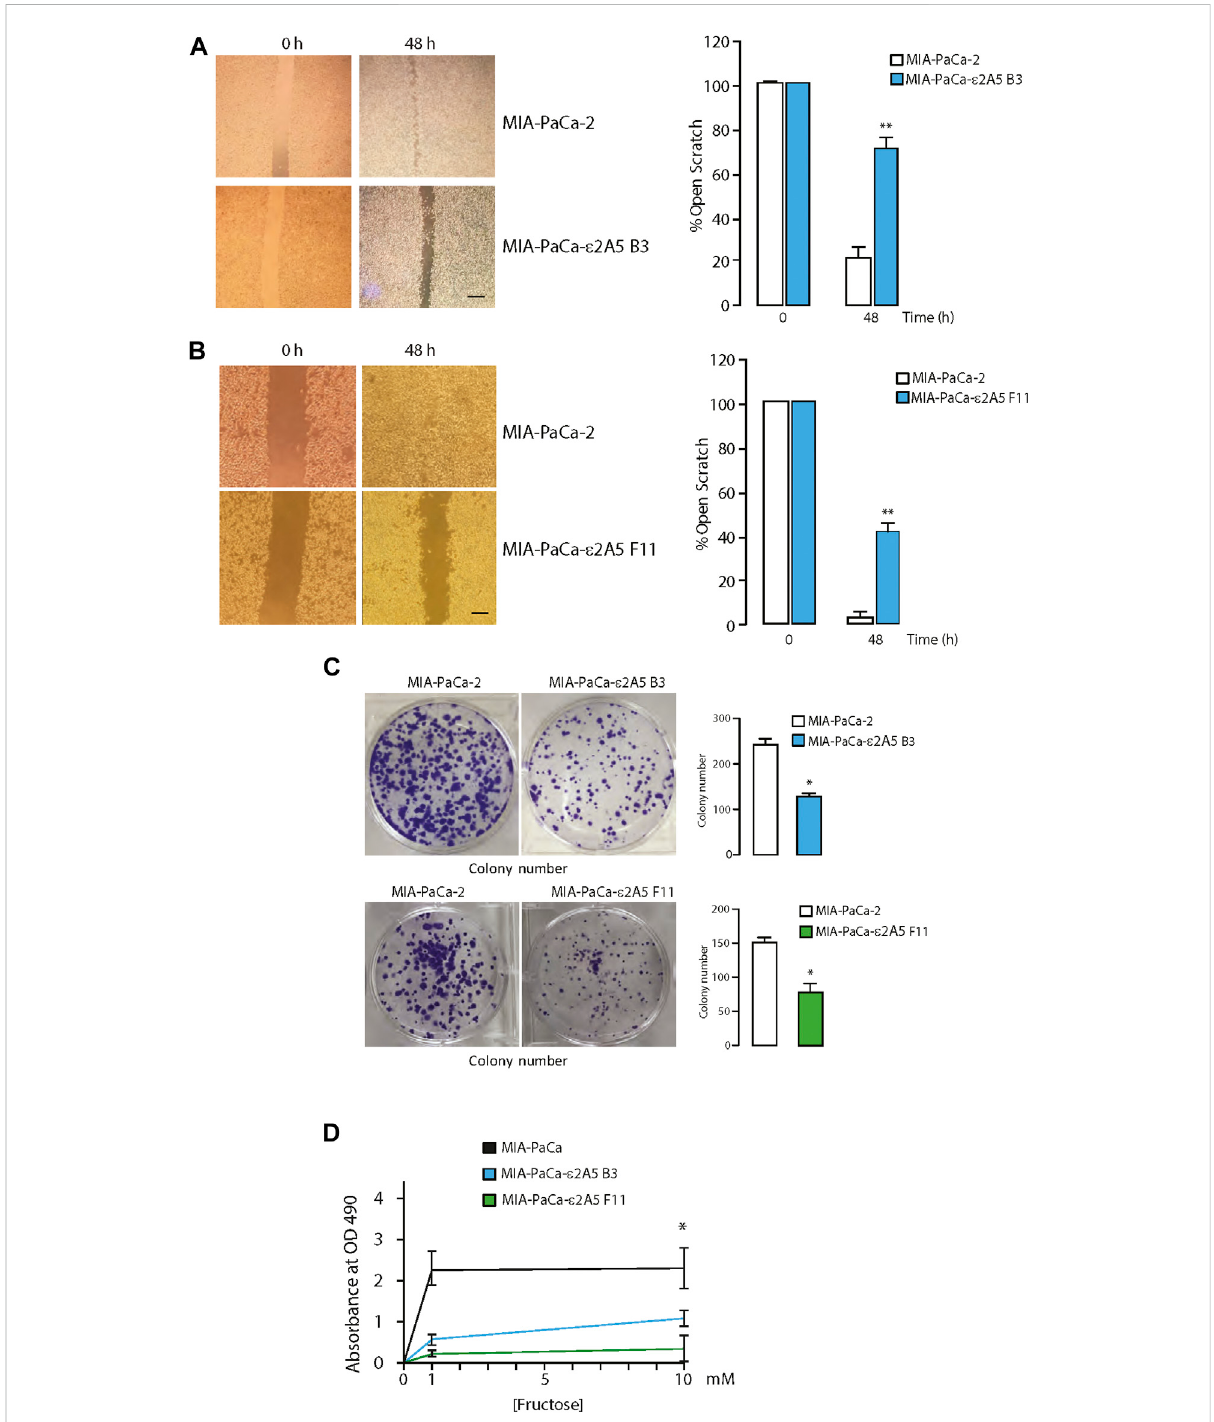
FIGURE 2 Attenuation of theSLC2A5 geneexpressioninpancreatic cancer cells. (A) .Imagesofscratch test(left panel) and quantitative analysis of closure (right panel) for MIA-PaCa-2 and MIA-PaCa- ε 2A5 cells (clone B3; ** p = 0.002, n = 3). Scale bar 10 µm. (B) . Scratch test analysis for MIA-PaCa-2 and MIA-PaCa- ε 2A5cell linescloneF11(** p =0.001,n=3).Scalebar10 µm. (C) .Colonyformationimagesandcolony numberfor MIA-PaCa- ε 2A5cells, clone B3 (left panel; 1000 cells/well plated at time 0 h; * p = 0.0001; n = 3) and clone F11 (right panel; 500 cells/well plated at time 0 h; * p = 0.001; n = 3). (D) . Fructose-dependent proliferation of the MIA-PaCa-2 and MIA-PaCa- ε 2A5 cells. MIA-PaCa-2 and MIA-PaCa- ε 2A5 (clones B3 and F11) cells were plated at a density of 1.0 × 10 4 cells/well of a 96 well plates. Fructose was added to the culture medium as indicated in the fi gure. The absorbance at 490 nm (OD 490 ) of the culture medium after MTS assay at time 0 and 48 h in culture are shown. Experiments were performed a minimum of three times in triplicates. * p = 0.0002; n =